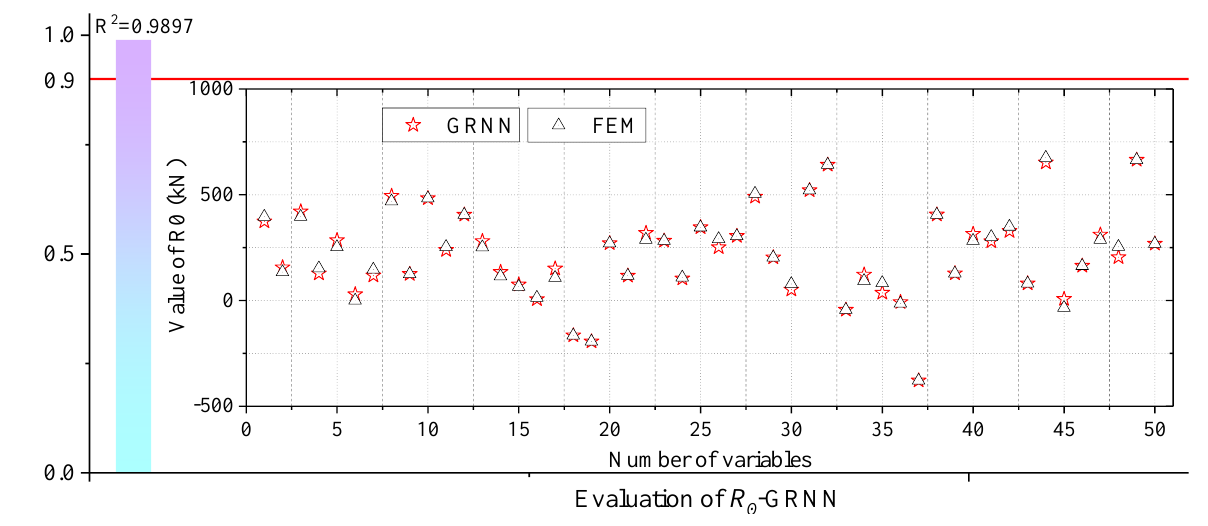
Figure 11. Structural response values from FEM and GRNN.